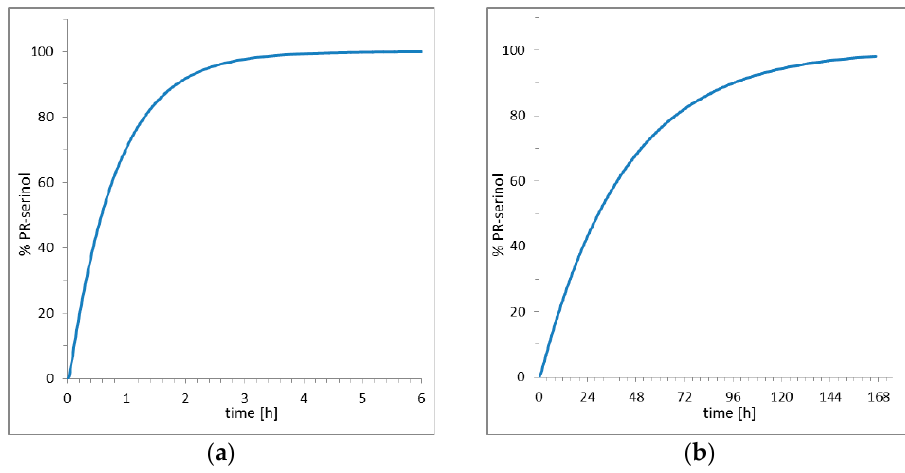
Figure 5. Simulation of diffusion, formation and complexation of amino diol derivative ( a ) hypothesis of reaction in PR/EPX crystal; ( b ) hypothesis of reaction in solution and diffusion into PR/EPX crystal.